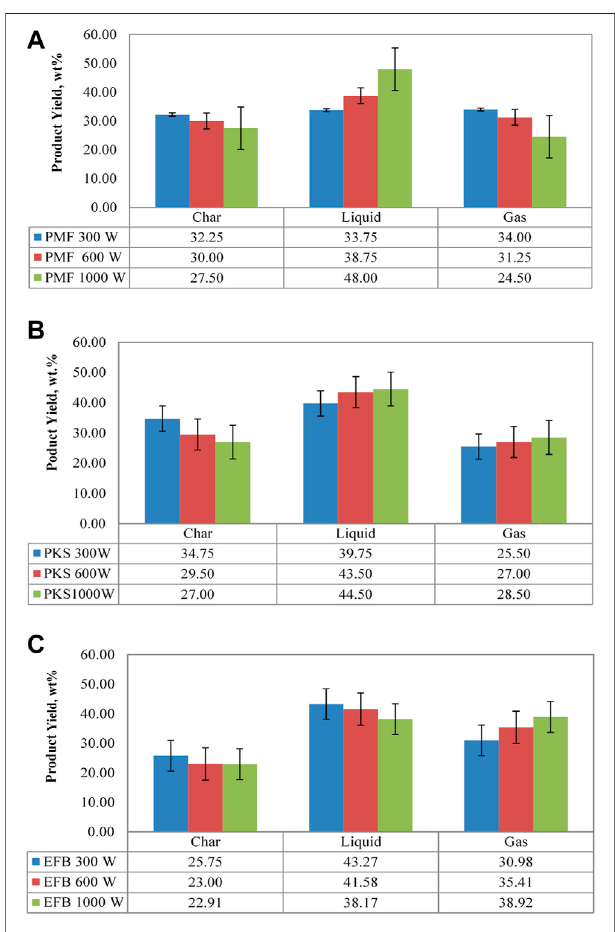
FIGURE 3 | Product distribution of (A) PMF, (B) PKS, and (C) EFB during microwave assisted pyrolysis at power level of 300, 600, and 1000 W.